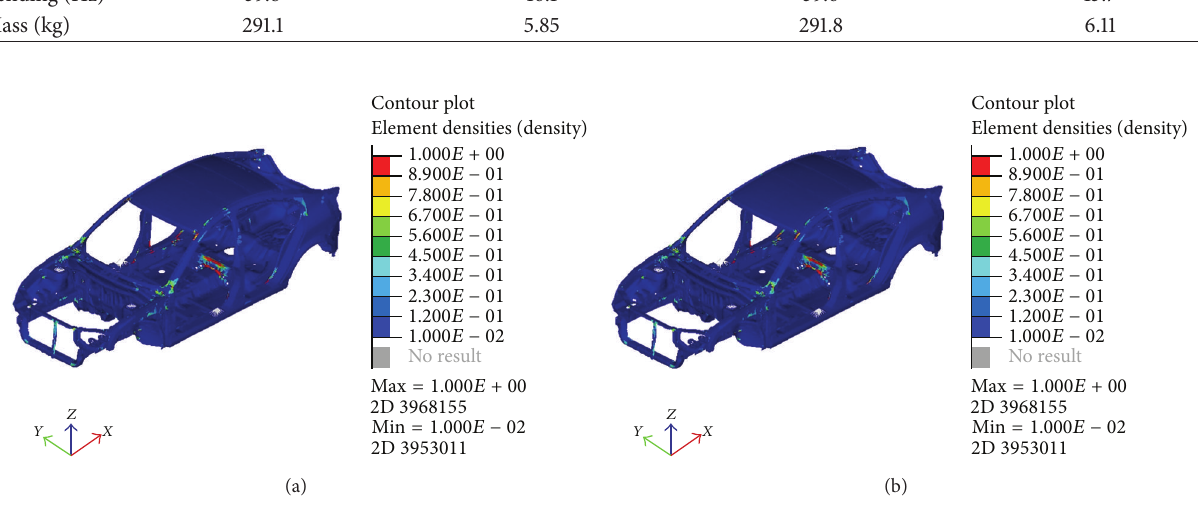
Figure 7: Optimization result using 3.2 mm (a) and 3.5 mm (b) maximum thickness